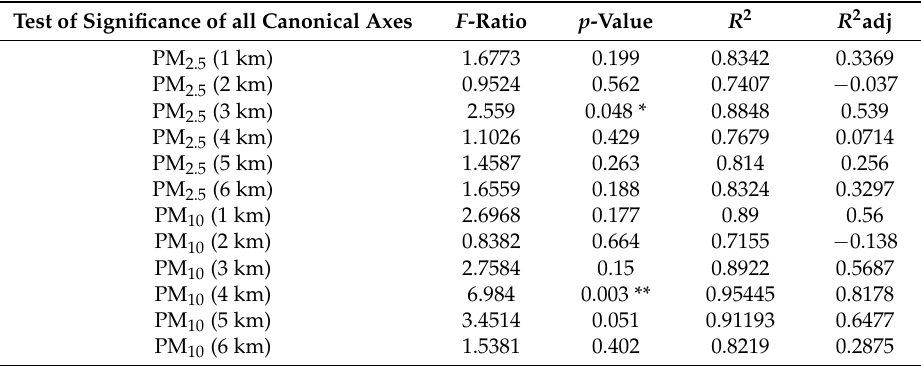
Table 3. Results of the Monte Carlo permutation